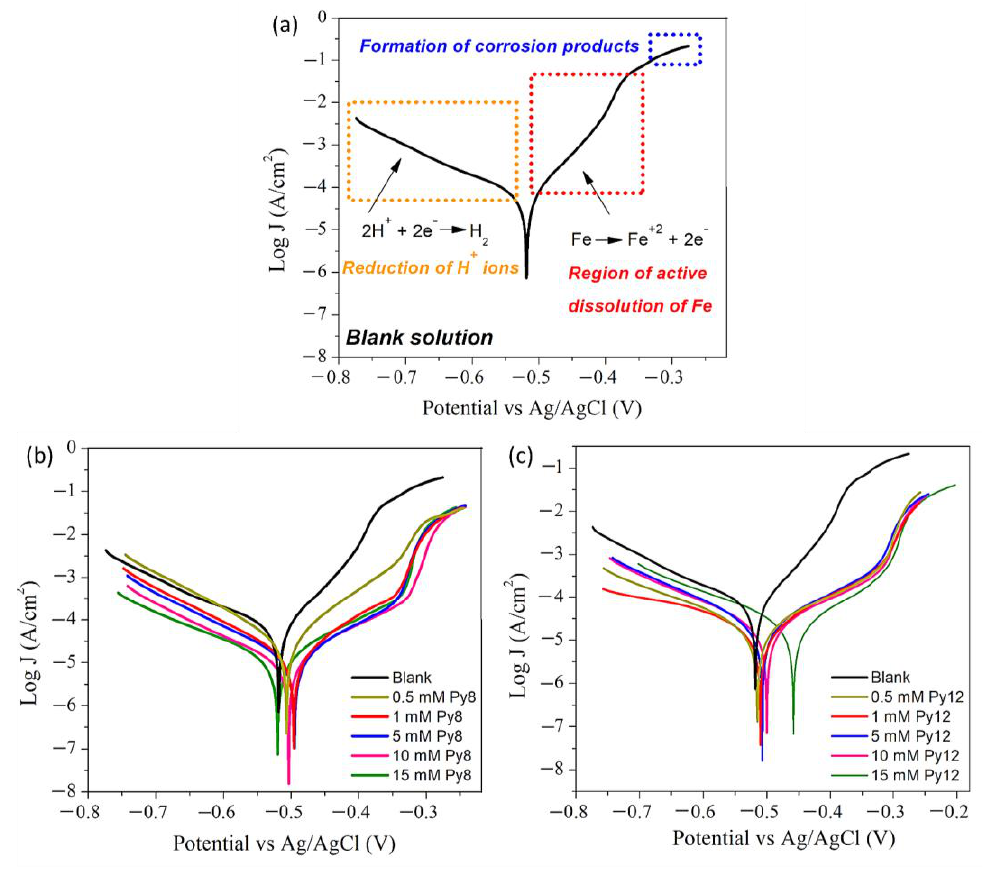
Figure 3. Tafel Polarization curves obtained for EN3B mild steel immersed in 3.5% NaCl solution (pH = 1.5) ( a ), and in the absence and presence of varying concentrations of surfactants ( b ) Py8 ( c ) Py12.